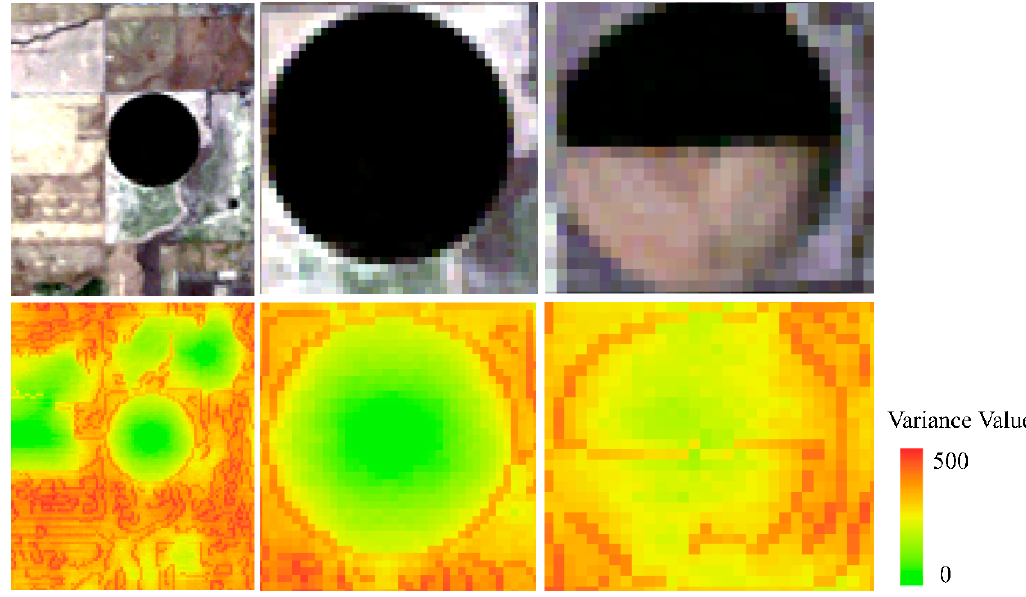
Figure 9. Center point of each center pivot irrigation system has the lowest variance value. Variance values of pixels were displayed by stretched colors from green to red. Green pixel indicates a low variance value, red pixel indicates a high variance value. Center points of the three center pivot systems were all displayed with green. Thus, the center point can be found by getting the lowest variance value among the nearest pixels, which are identified as center pivot systems by the classifier. In our experiments, 13 pixel sets toward different orientations were used for the calculation of the variance value for each pixel. Formula (2) was used for the variance calculation. (cid:1833)(cid:1870)(cid:1853)(cid:1877) = 0.299 × (cid:1844)(cid:1857)(cid:1856) + 0.587 × (cid:1833)(cid:1870)(cid:1857)(cid:1857)(cid:1866) + 0.114 × (cid:1828)(cid:1864)(cid:1873)(cid:1857)